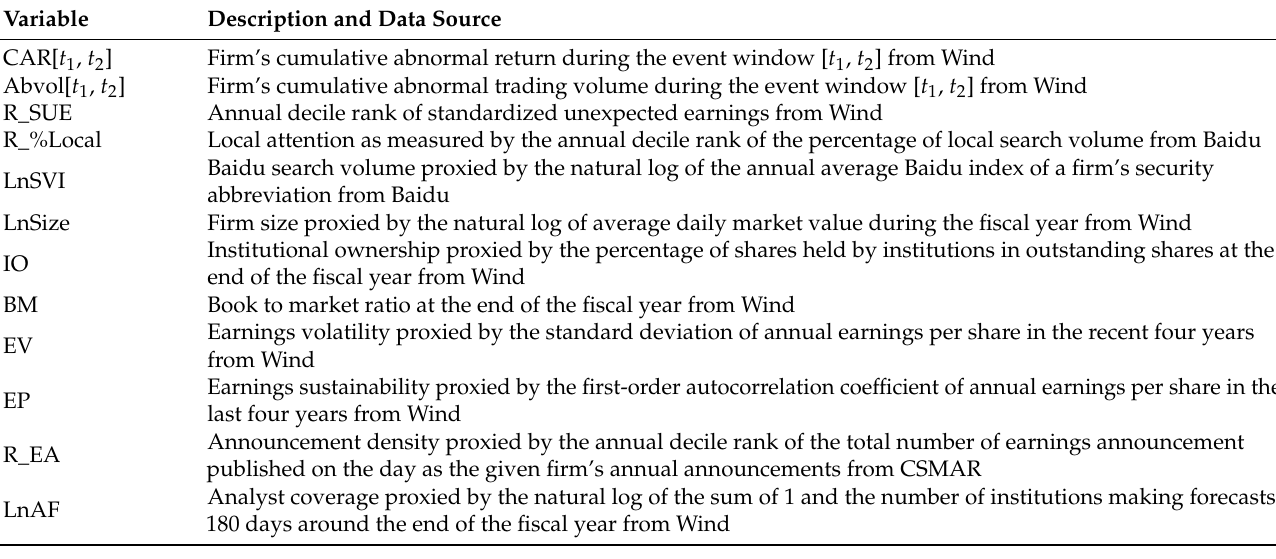
Table A2. List of Description and Data Source of Main